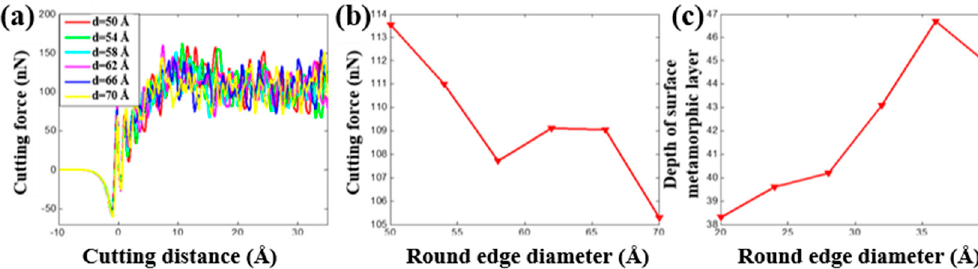
Figure 14. The cutting force and depth of the surface metamorphic layer obtained from MD by varying